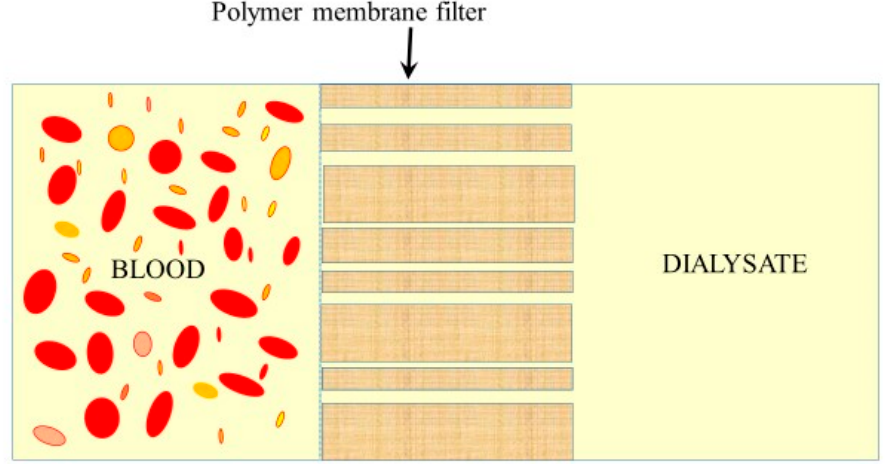
Figure 4. Schematics of the hemodialysis filtration.